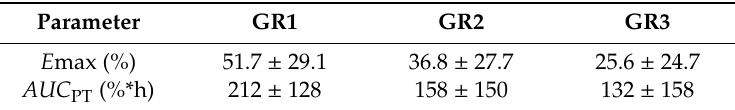
Figure 3. ( A ) PT profile and ( B ) percentage increase in PT of the blood samples under the control of RIV with / without CBZ / PHT pretreatment. Each point represents the mean and standard deviation. Table 2. PD parameters (mean ± SD) of RIV with / without CBZ / PHT pretreatment. GR1, RIV alone ( n = 11); GR2, RIV administered with CBZ ( n = 6); GR3, RIV administered with PHT ( n =